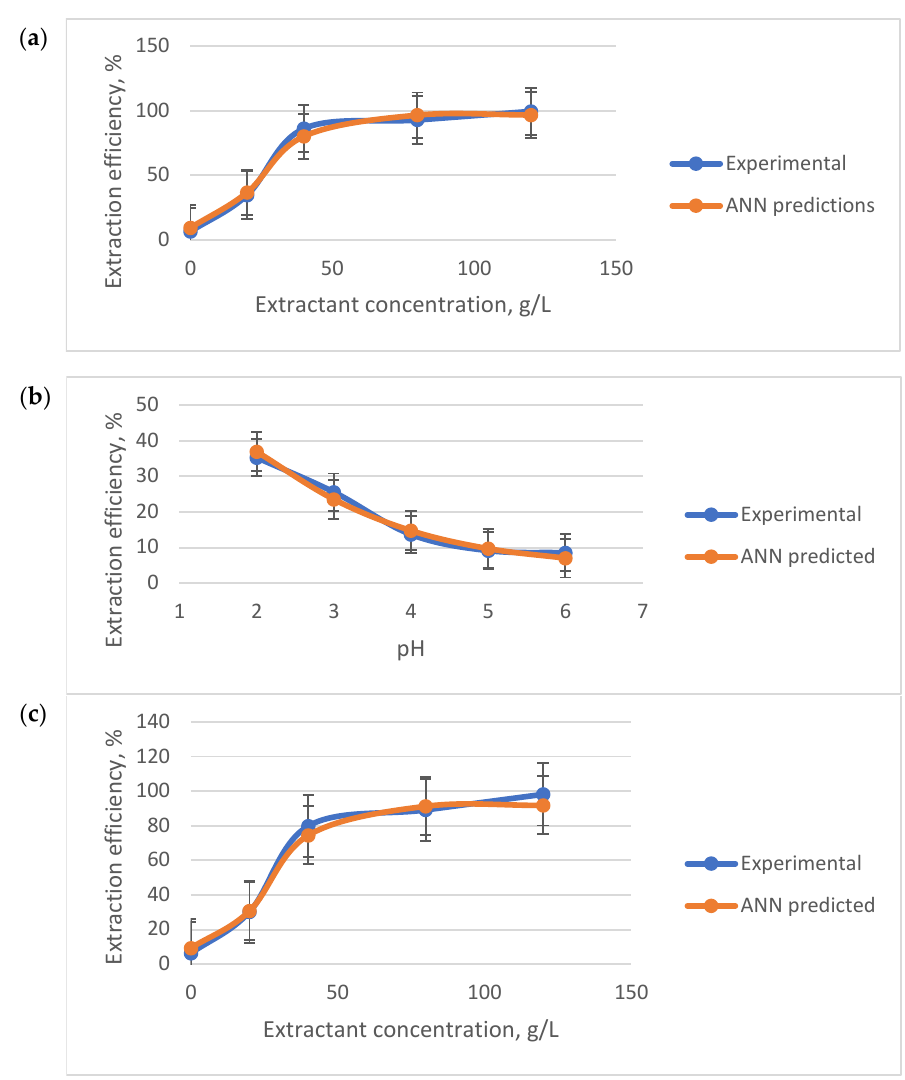
Figure 7. Comparison between the experimental data and the ANN predictions for ( a ) Heptane and CYPHOS IL103 when pH = 4; ( b ) chloroform and [HMIM][PF 6 ] when extractant concentration is 40; ( c ) Heptane and CYPHOS IL104 when pH = 4.